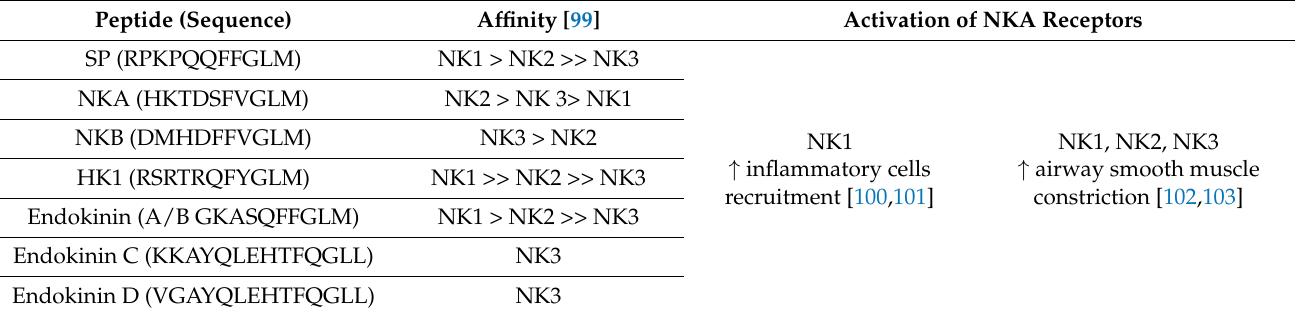
Table 2. Alignment of the amino acid sequence of the mammalian tachykinin and their preferences for tachykinin receptors [99]. The role of NKA receptors in